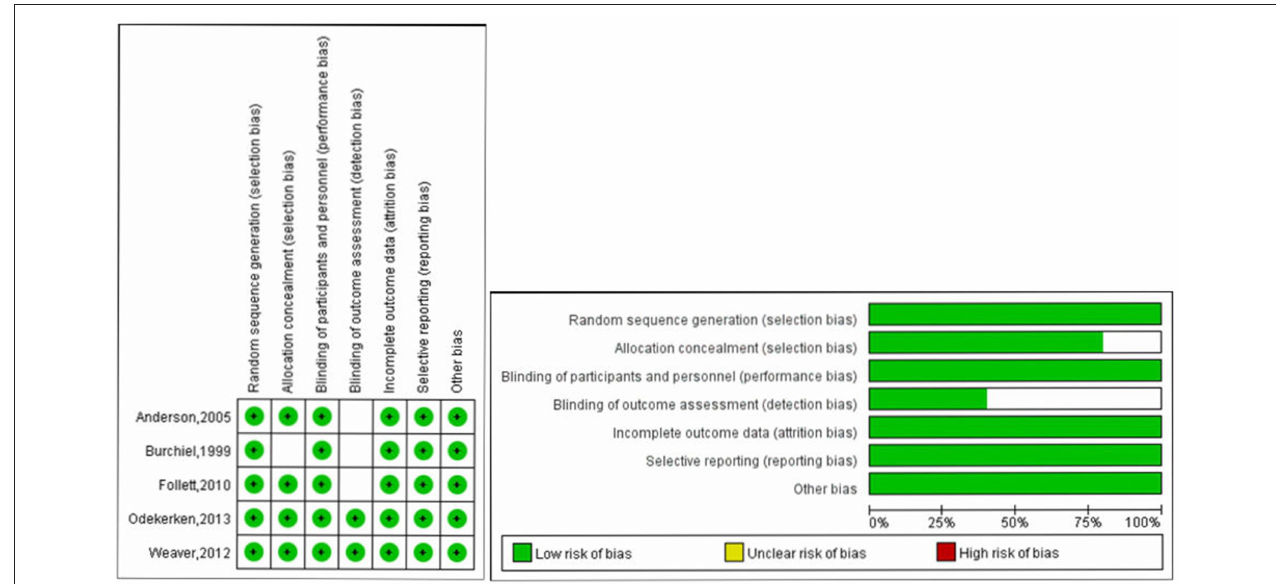
FIGURE 2 | Quality assessment of RCTs using Cochrane collaboration’s tool for assessing risk of bias.